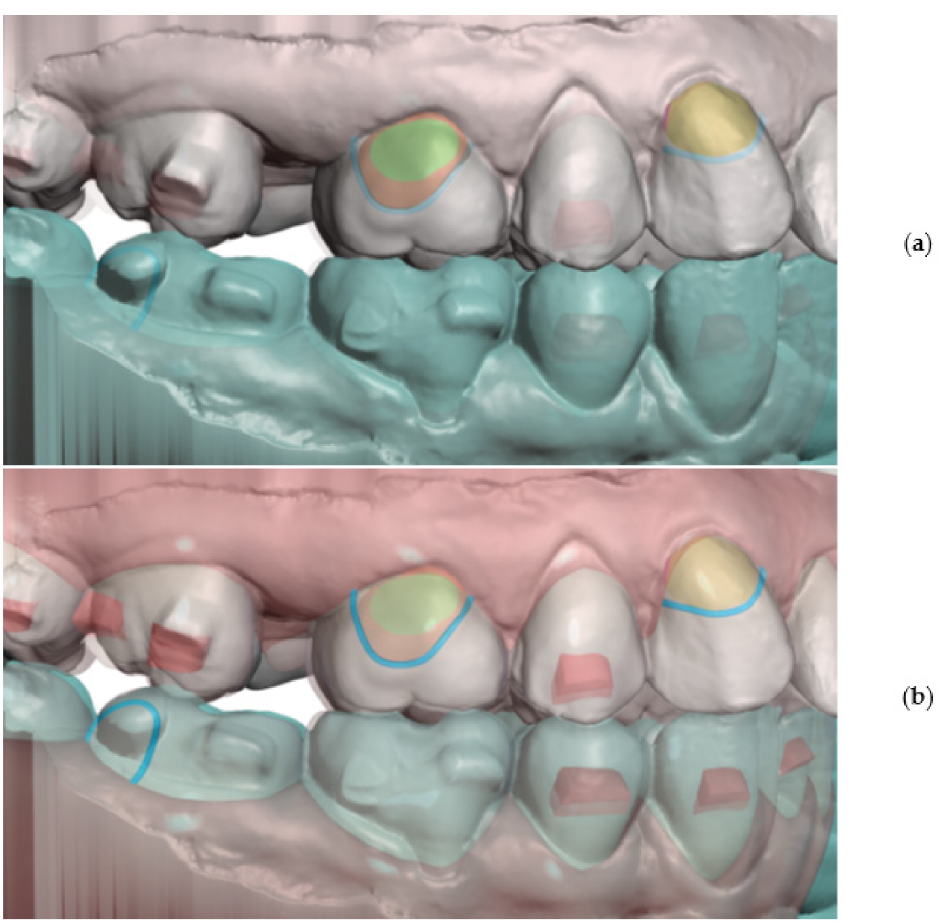
Figure 6. Overlay of intraoral scan ( a ) with a software model from CAT planning ( b ) is important to identify the areas of aligner cut-outs. These will be the contacts of distalizer with teeth